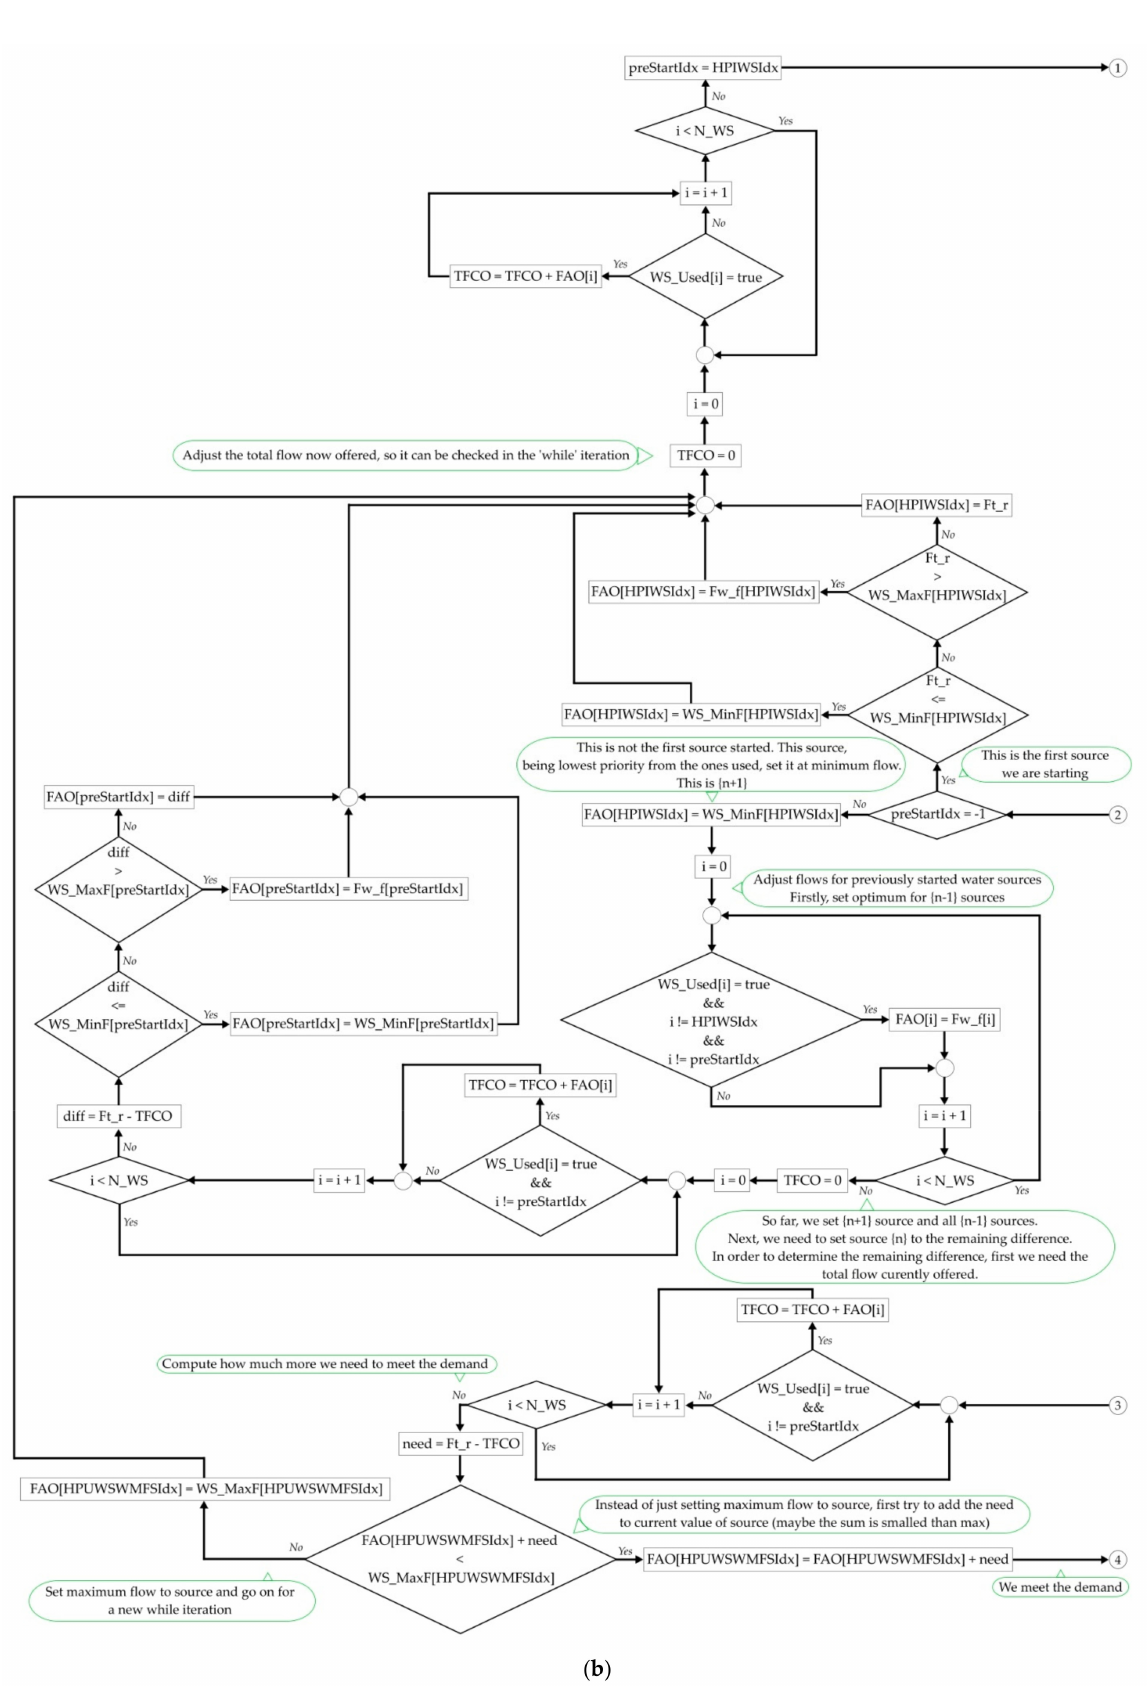
Figure 7. Detailed perspective of the implemented algorithm for dividing the total requested water flow into specific flows for each source, in an optimum way for reducing energy consumption, ( a ) right side of the diagram, ( b ) left side of the